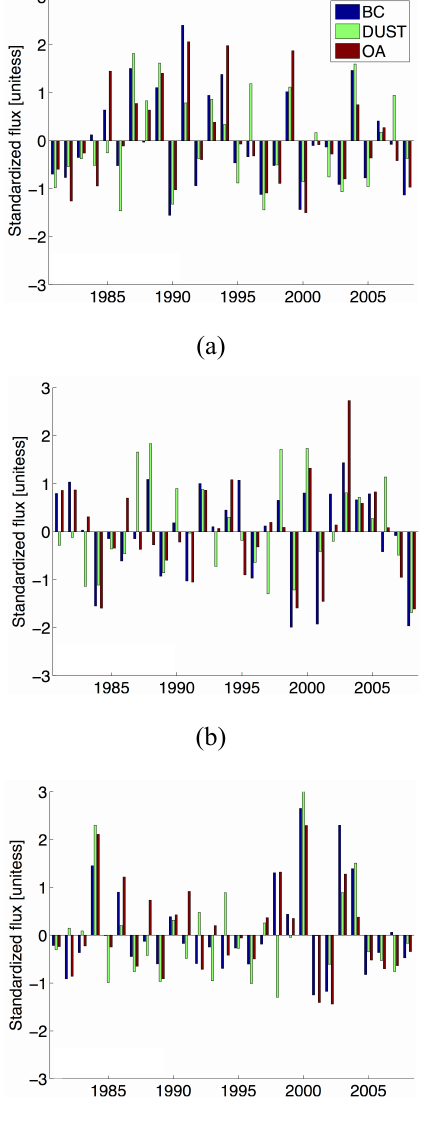
Figure 9. NASA GISS ModelE standardized deposition fluxes for BC, dust, and organic aerosol (OA) at Kangerlussuaq for (a) June, (b) July, and (c) August (1981–2008) from the AEROCOM simula- tions.